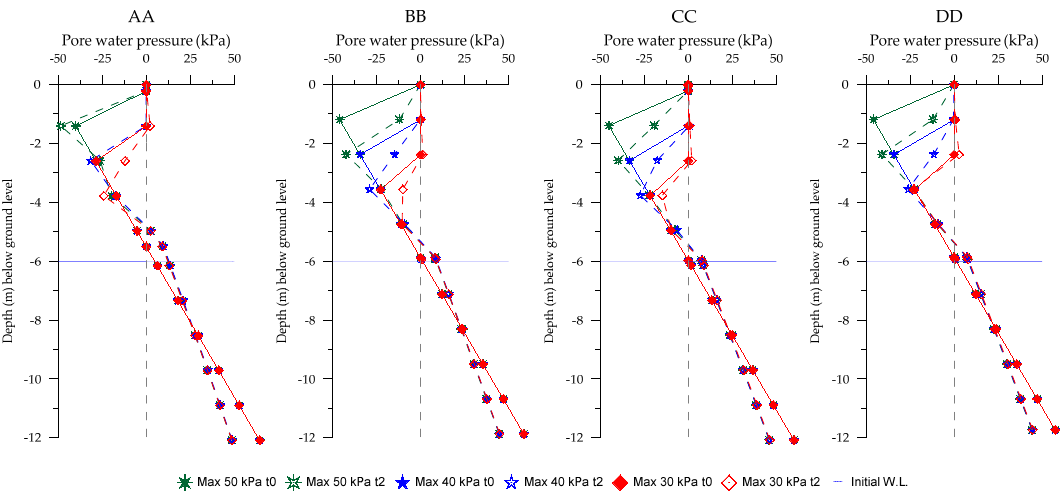
Figure 4. Initial pore pressure profiles.